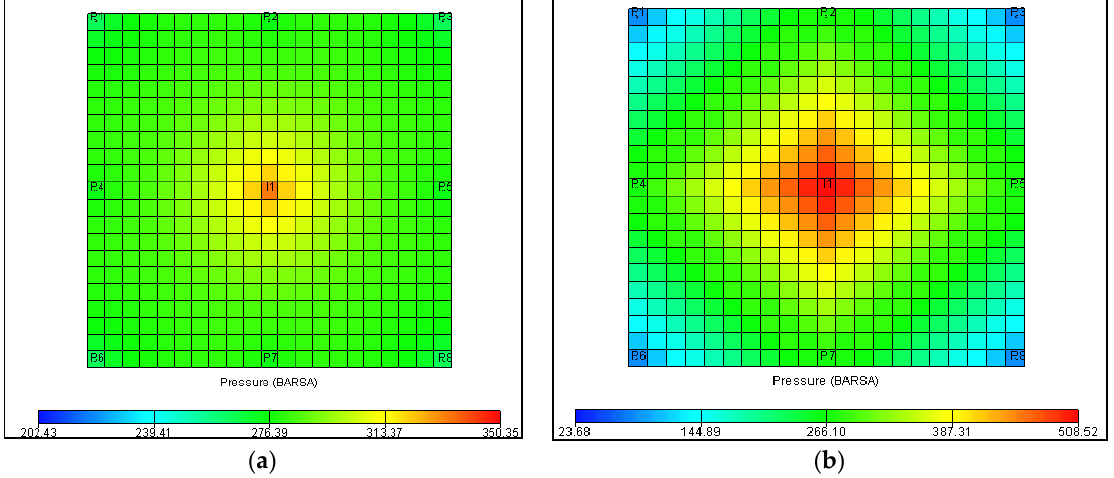
Figure 10. Pressure distribution map on March: ( a ) Darcy seepage; ( b ) non-Darcy seepage.